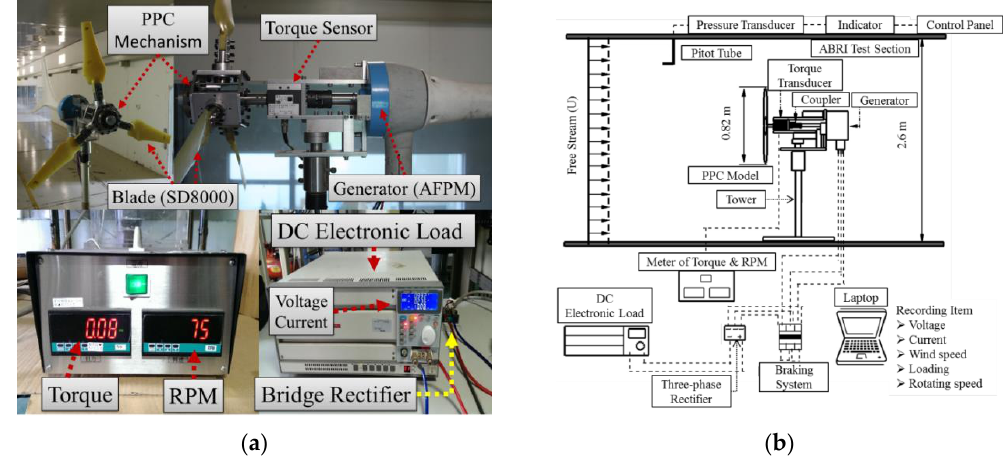
Figure 11. ABRI wind tunnel tests: ( a ) the small-scale HAWT prototype and its PPC mechanism; and ( b ) experimental setups.